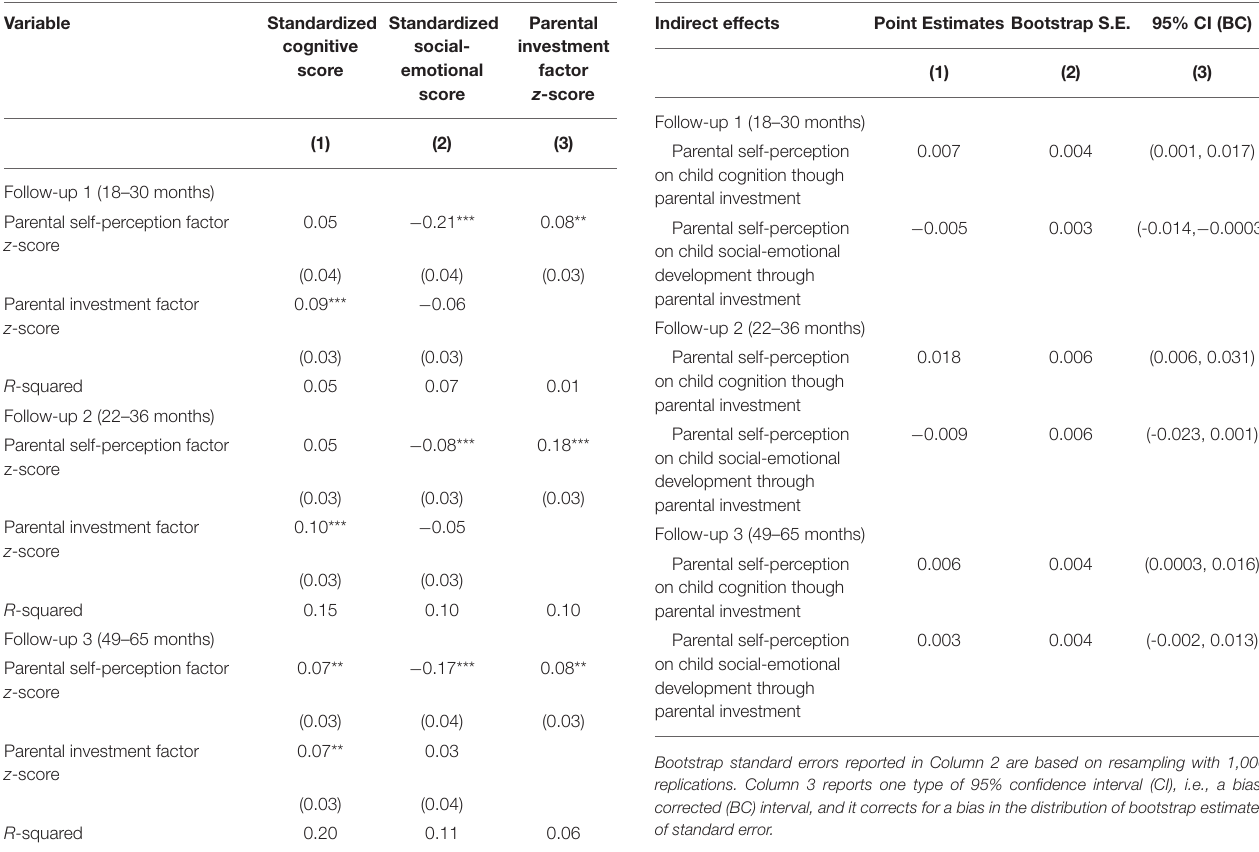
TABLE 5 | Estimates of indirect effects of parental self-perception on child developmental outcomes through parental